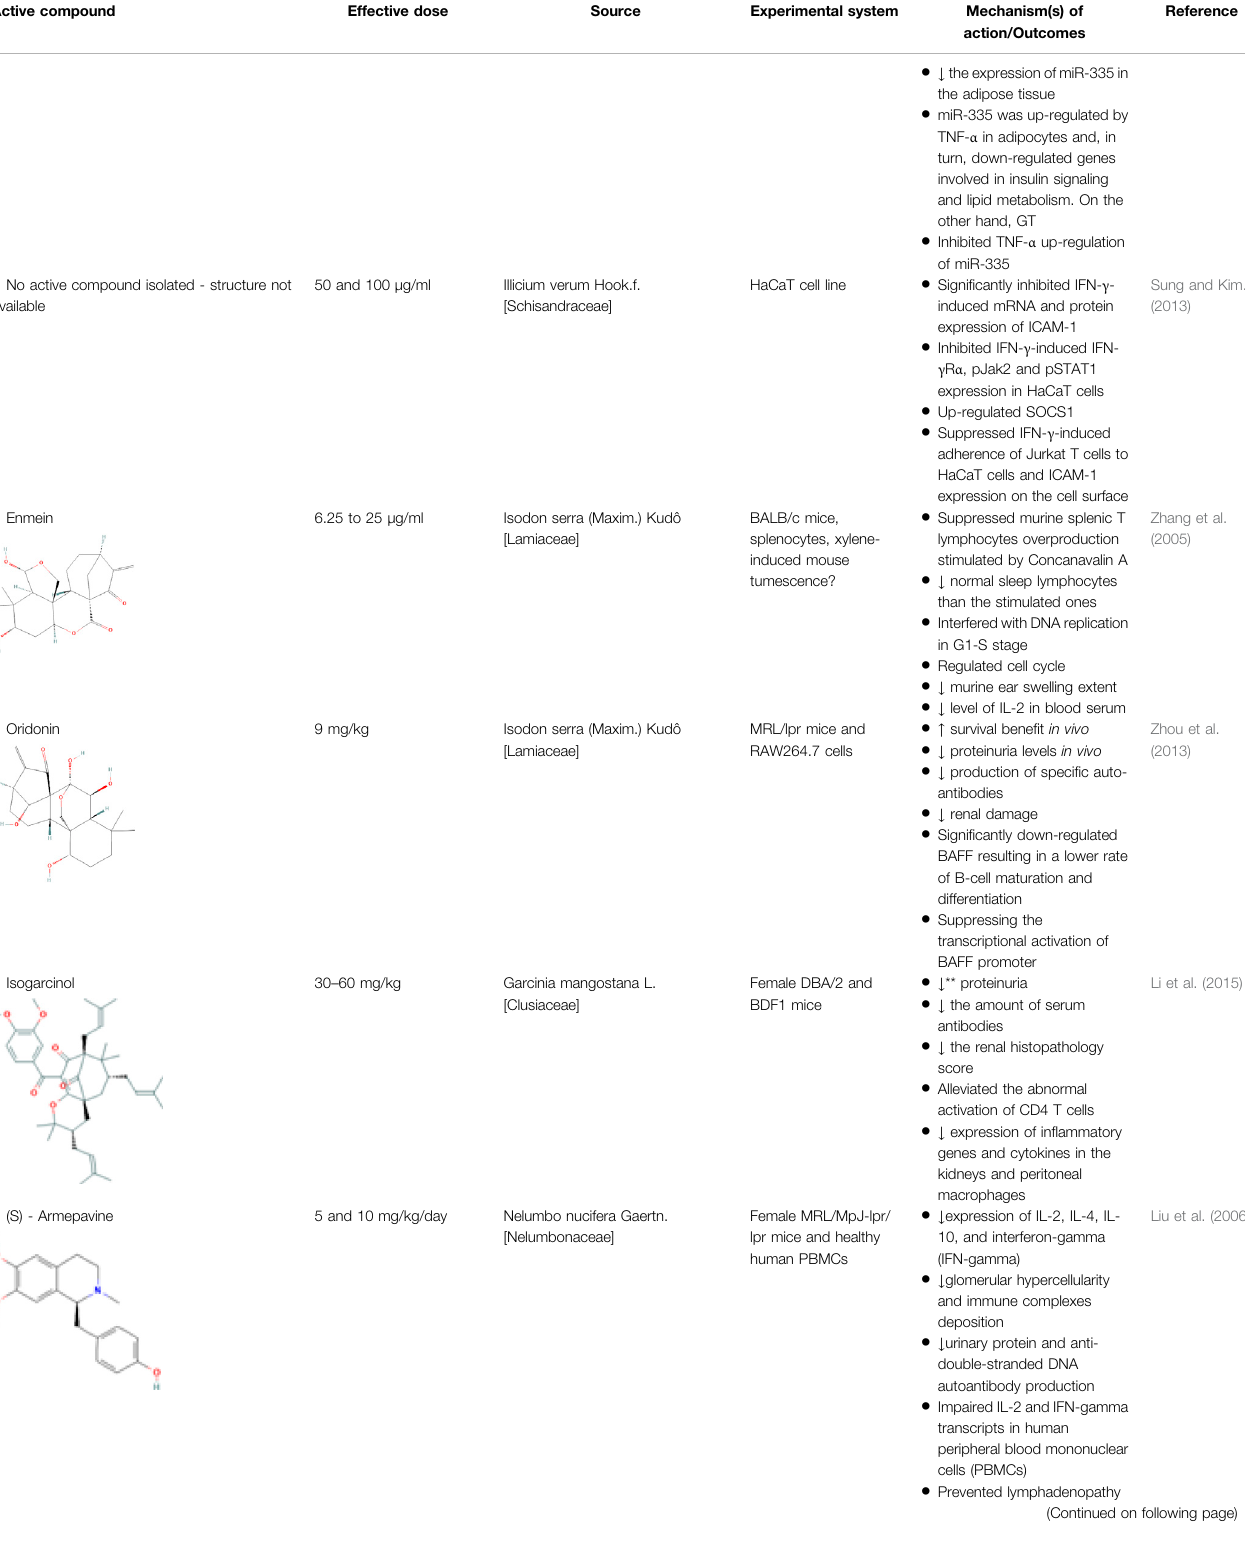
TABLE 1 | ( Continued ) Synthesized fi ndings for potential bioactive compounds for